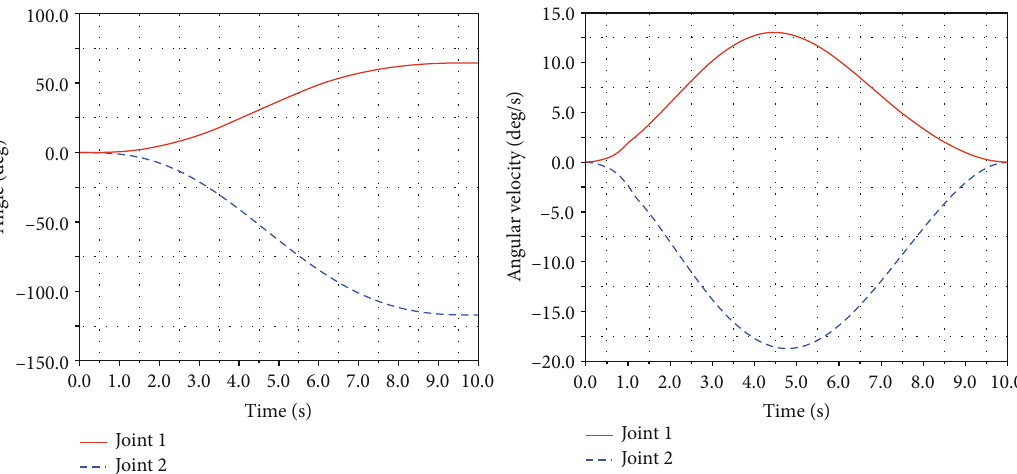
Figure 9: Optimized trajectories of joints for the planning case of attitude adjustment.